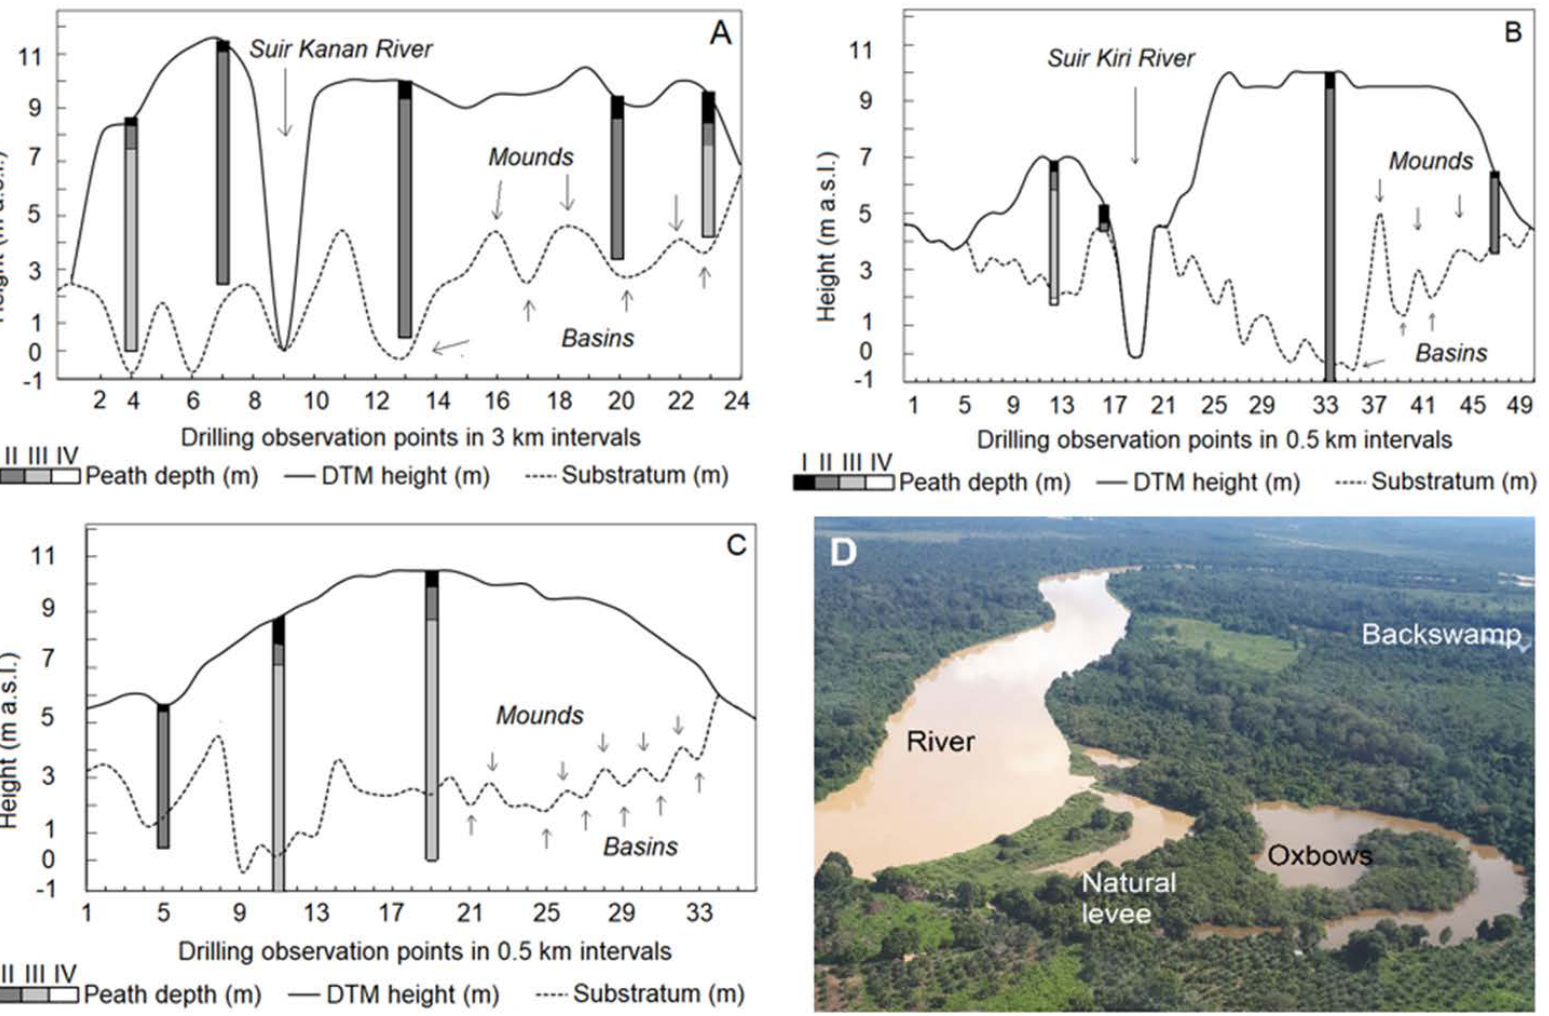
Figure 8. Conceptualised profiles of surface and substratum topography along the three surveyed transects on Tebing Tinggi Island (A: Transect LS; B: Transect CS1; C: Transect CS2), also showing the locations and peat layers (I –IV) of the twelve cores selected for laboratory examination; and (D) visualisation of river morphology in the form of natural levées, meanders, oxbow lakes and backswamp. Photo: Azwar